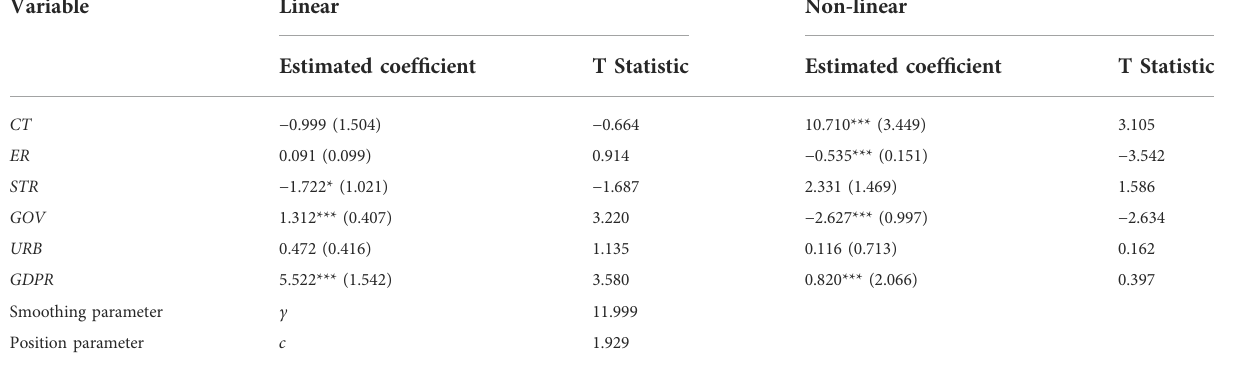
TABLE 5 PSTR model estimation results.